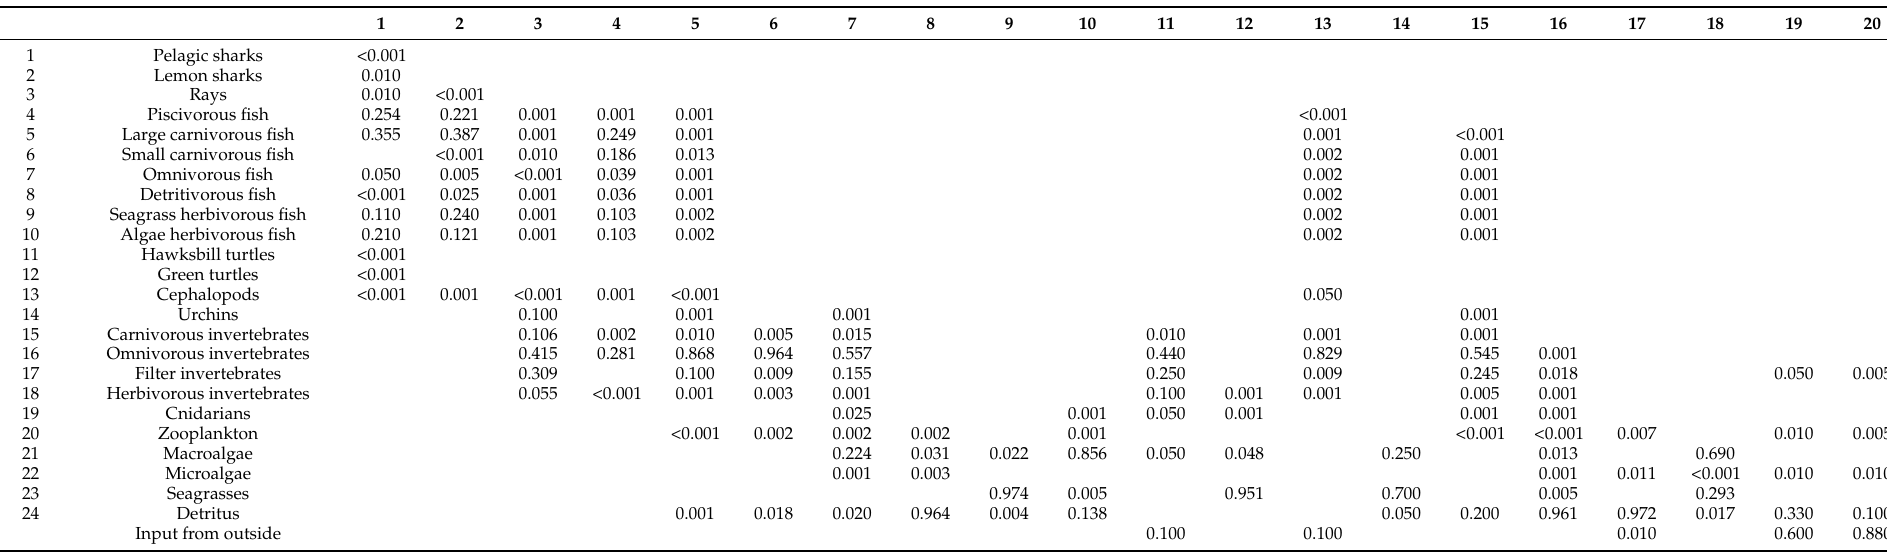
Table 2. Diet composition matrix in percentage of prey groups (in rows) for each consumer group (in columns) for the Dongsha seagrass bed